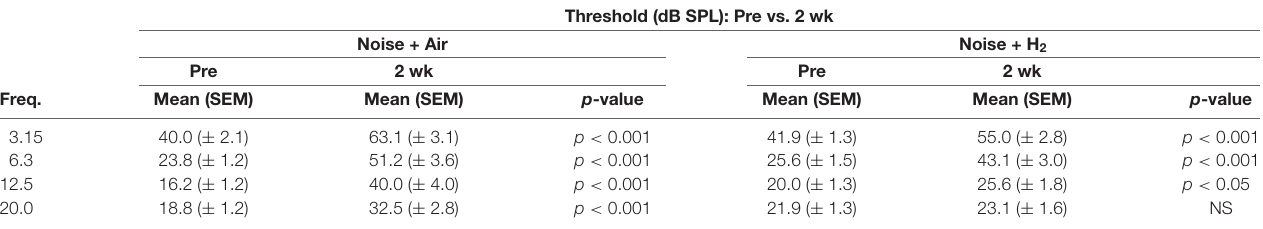
TABLE 1 | A comparison of auditory brainstem response (ABR) thresholds obtained at baseline prior to noise exposure and at 2 weeks in the 2w + air and 2w + H 2 groups. Threshold (dB SPL): Pre vs. 2 wk Noise + Air Noise + H